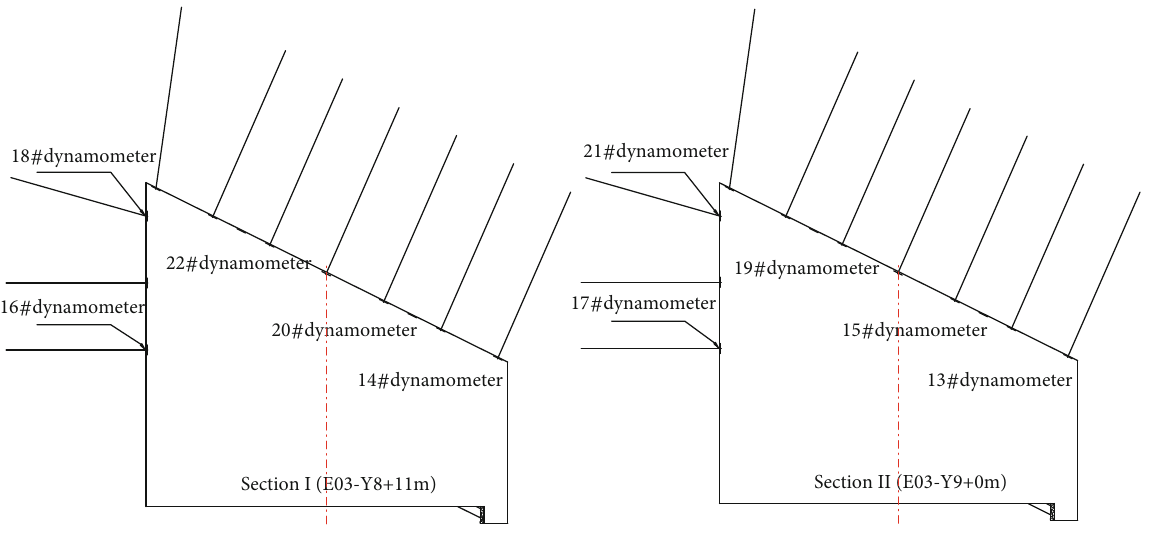
Figure 10: Cross-sectional view: support stress and displacement monitoring in the E0103 transport channel. Table 4: Monitoring data of mining